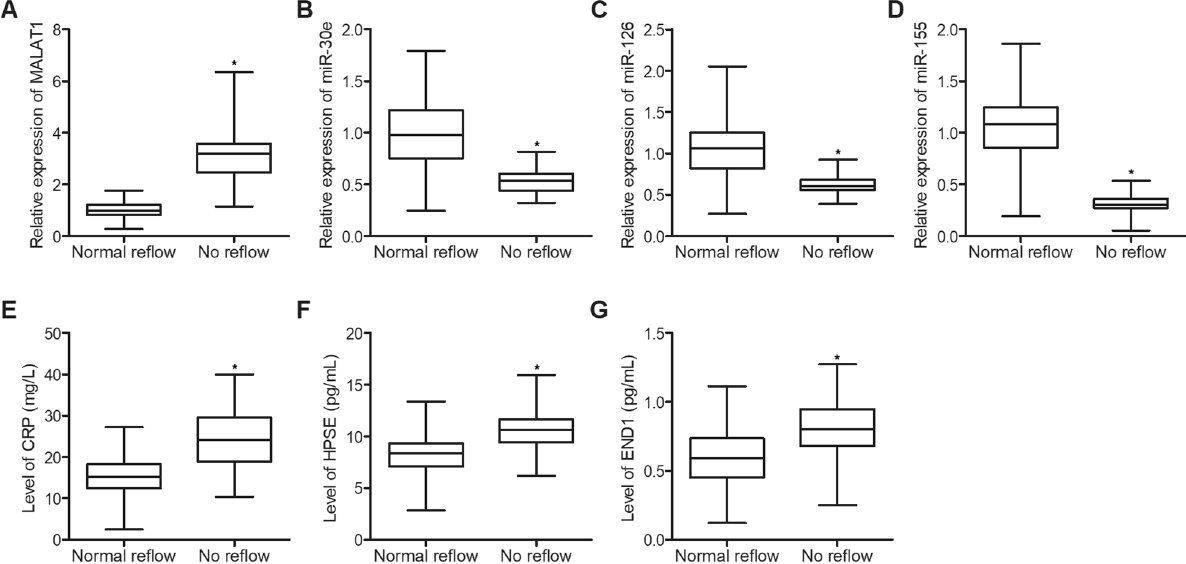
Figure 1. Differential expression of MALAT1, miR-30e, miR-126, miR-155, CRP, HPSE and EDN1 in the plasma of STEMI patients receiving pPCI (*P value < 0.05 vs. normal reflow group). ( A ) The expression of MALAT1 was enhanced in the plasma of STEMI patients receiving pPCI who were diagnosed with no-reflow phenomenon when compared with patients with normal reflow. ( B ) The expression of miR-30e was suppressed in the plasma of STEMI patients receiving pPCI who were diagnosed with no-reflow phenomenon when compared with patients with normal reflow. ( C ) The expression of miR-126 was suppressed in the plasma of STEMI patients receiving pPCI who were diagnosed with no-reflow phenomenon when compared with patients with normal reflow. ( D ) The expression of miR-155 was suppressed in the plasma of STEMI patients receiving pPCI who were diagnosed with no-reflow phenomenon when compared with patients with normal reflow. ( E ) The expression of CRP was increased in the plasma of STEMI patients receiving pPCI who were diagnosed with no-reflow phenomenon when compared with patients with normal reflow. ( F ) The expression of HPSE was increased in the plasma of STEMI patients receiving pPCI who were diagnosed with no-reflow phenomenon when compared with patients with normal reflow. ( G ) The expression of EDN1 was increased in the plasma of STEMI patients receiving pPCI who were diagnosed with no-reflow phenomenon when compared with patients with normal